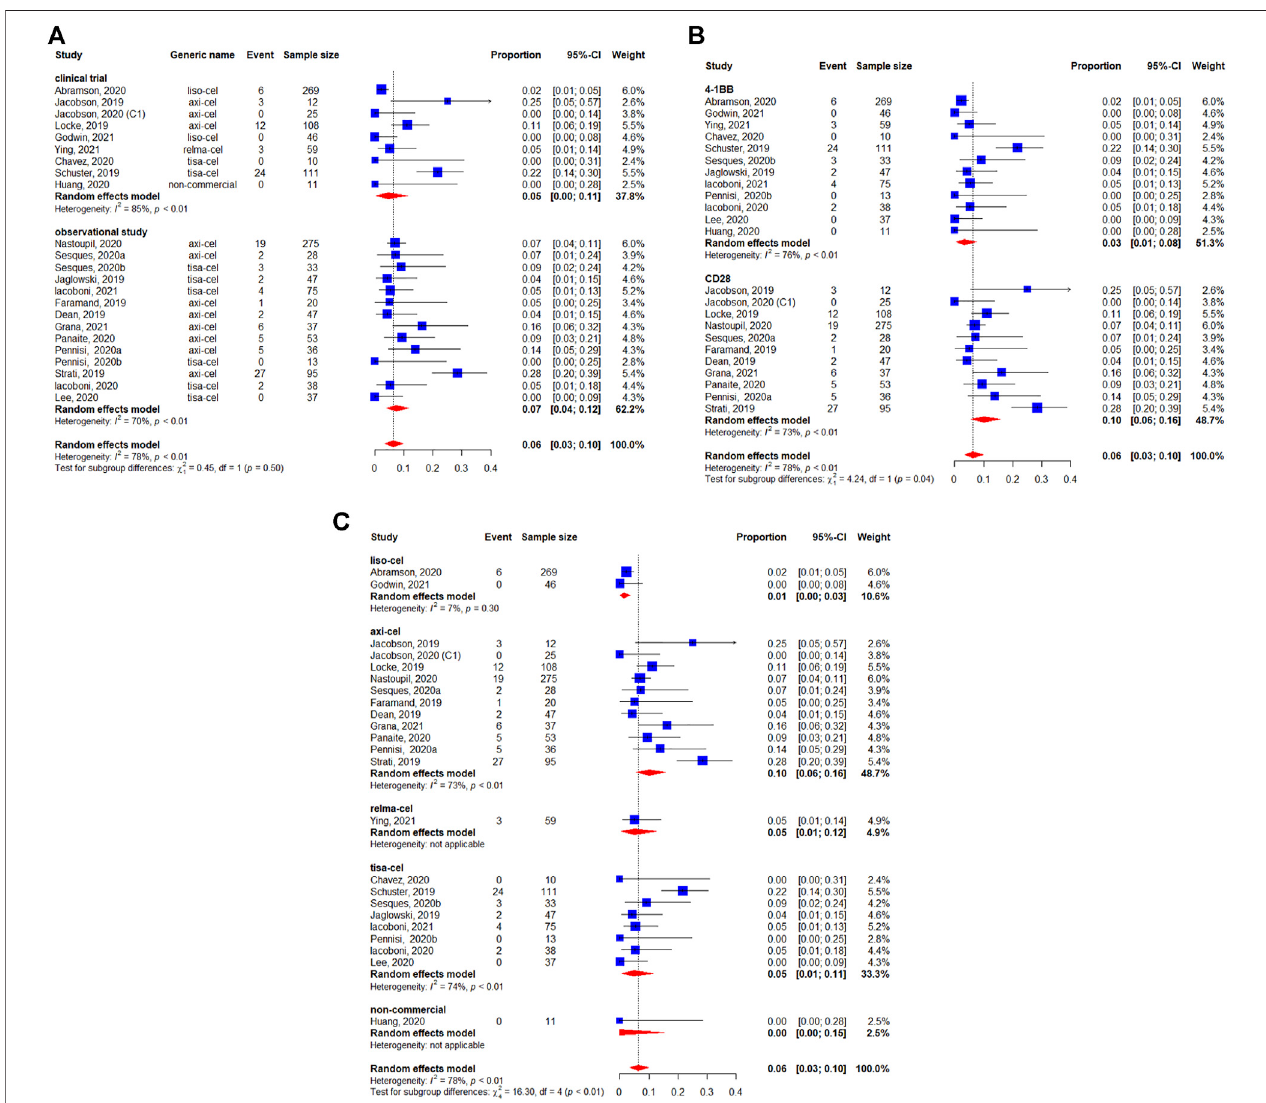
FIGURE 7 | Severe (grade ≥ 3) cytokine release syndrome (CRS) of patients with diffuse large B-cell lymphoma (DLBCL) treated with chimeric antigen receptor T cells (CAR-Ts) according to (A) study design, (B) the costimulatory domain, and (C) type of chimeric antigen receptor T cells (CAR-T).